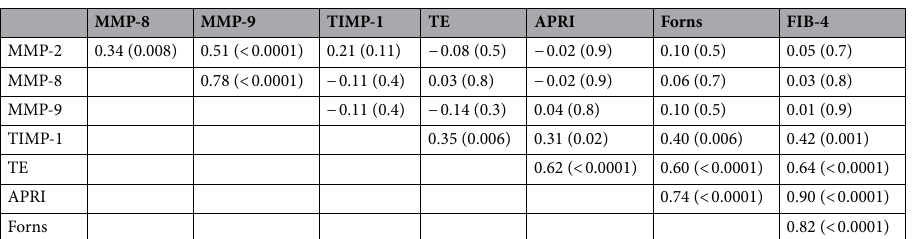
Table 2. Correlations between MMPs, TIMP-1 and fibrosis parameters. r (P value). TE denotes transient